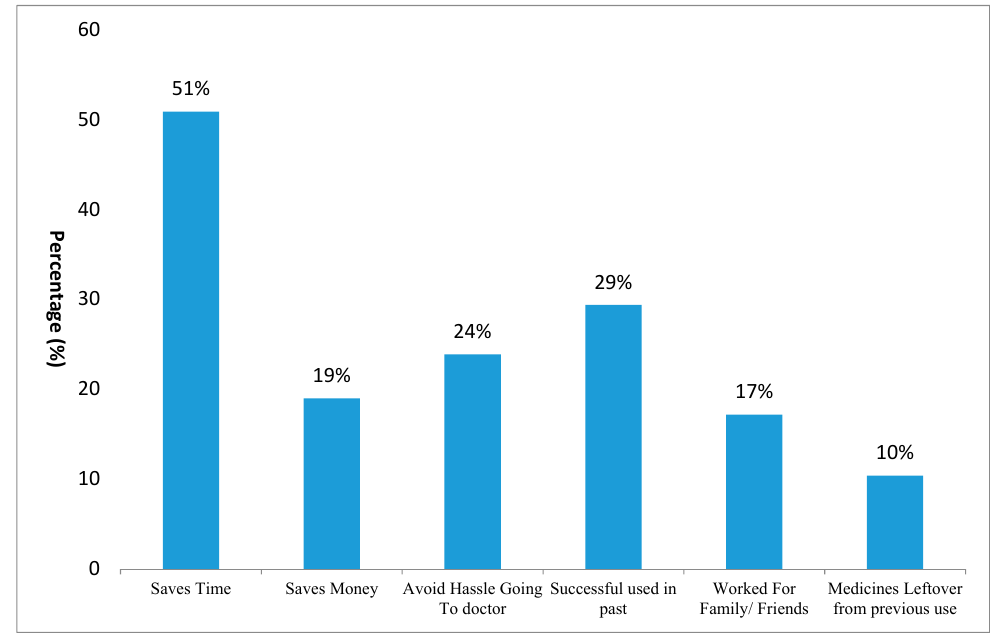
Figure 1. Factors leading to the self-medication (SM) of antibiotics in non-medical students from universities.